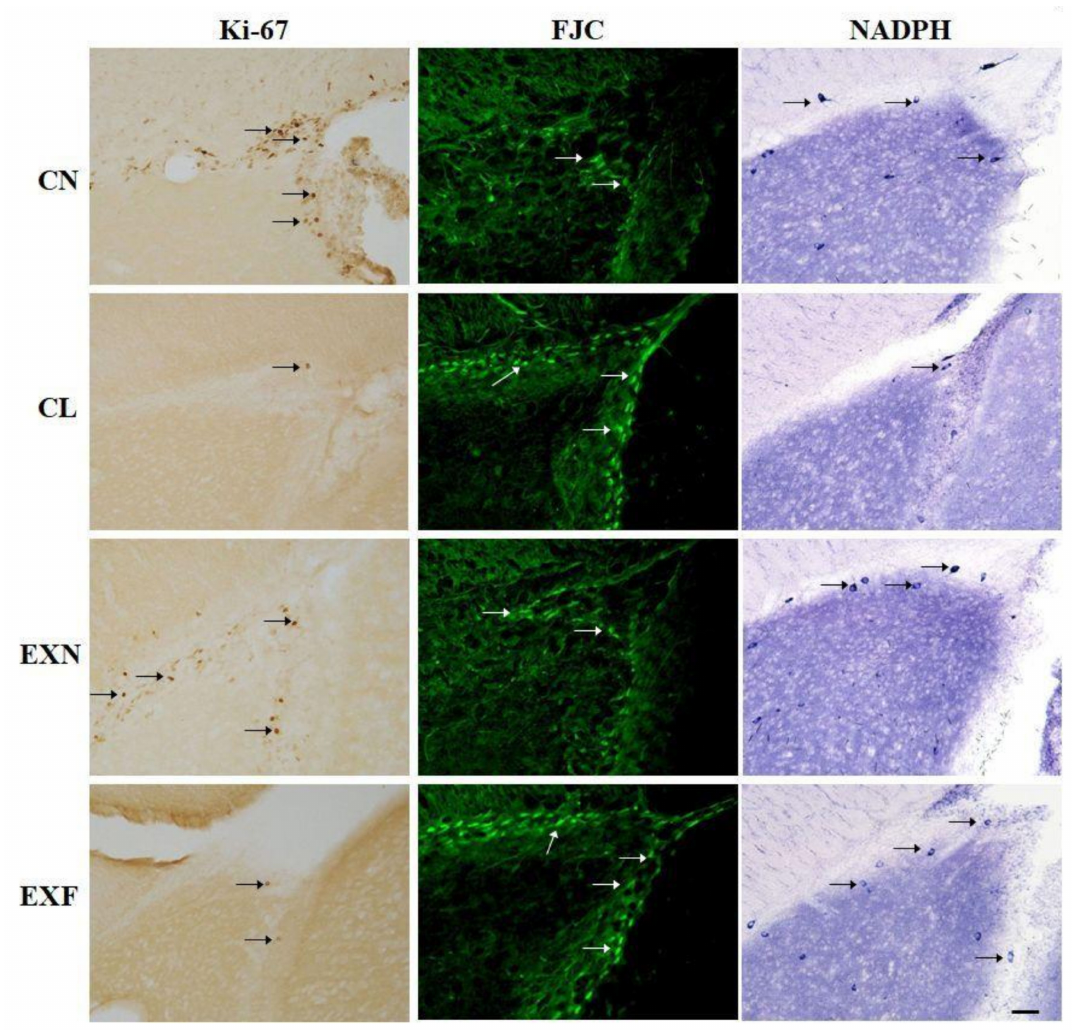
Figure 2. Changes in adult neurogenesis in the subventricular zone of mice with various body conditions. (column one) Immunohistochemical staining of proliferating cells by means of Ki-67 ( brown ) was performed to examine the effect of HED on cell proliferation in the SVZ/RMS; (column two) fluoro-jade C labelling was performed to identify degenerating cells ( green ); (column three) effect of maternal overnutrition on the distribution of nitrergic cells, arrows stand for the NADPH- d-positive cells. Abbreviations: (CN) control group of mice characterized by normal weight and physiological percentage of body fat deposits; (CL) control group of mice characterized by reduced weight and reduced body fat deposits; (EXN) experimental group of mice characterized by normal weight and moderately elevated body fat deposits; (EXF) experimental group of mice characterized by markedly elevated weight and body fat deposits. Scale bar = 50 µ